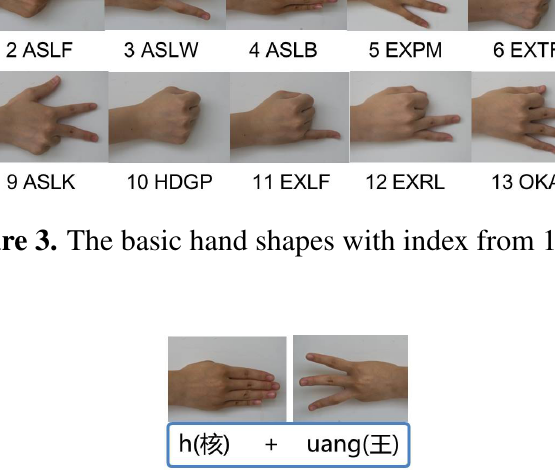
Figure 4. The phonology-coded gestures of Chinese character pronunciation